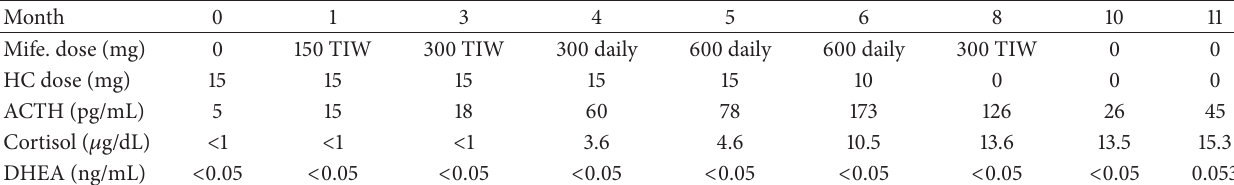
Table 1: Time course of HPA axis recovery after initiation of